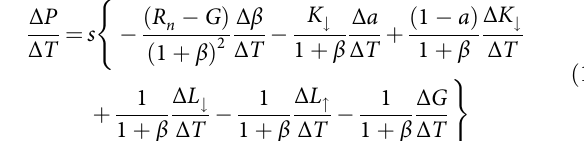
Table 2). For example, the Bowen ratio temperature sensitivity Δ β / Δ T of − 0.0083 K − 1 is obtained from the Priestley – Taylor